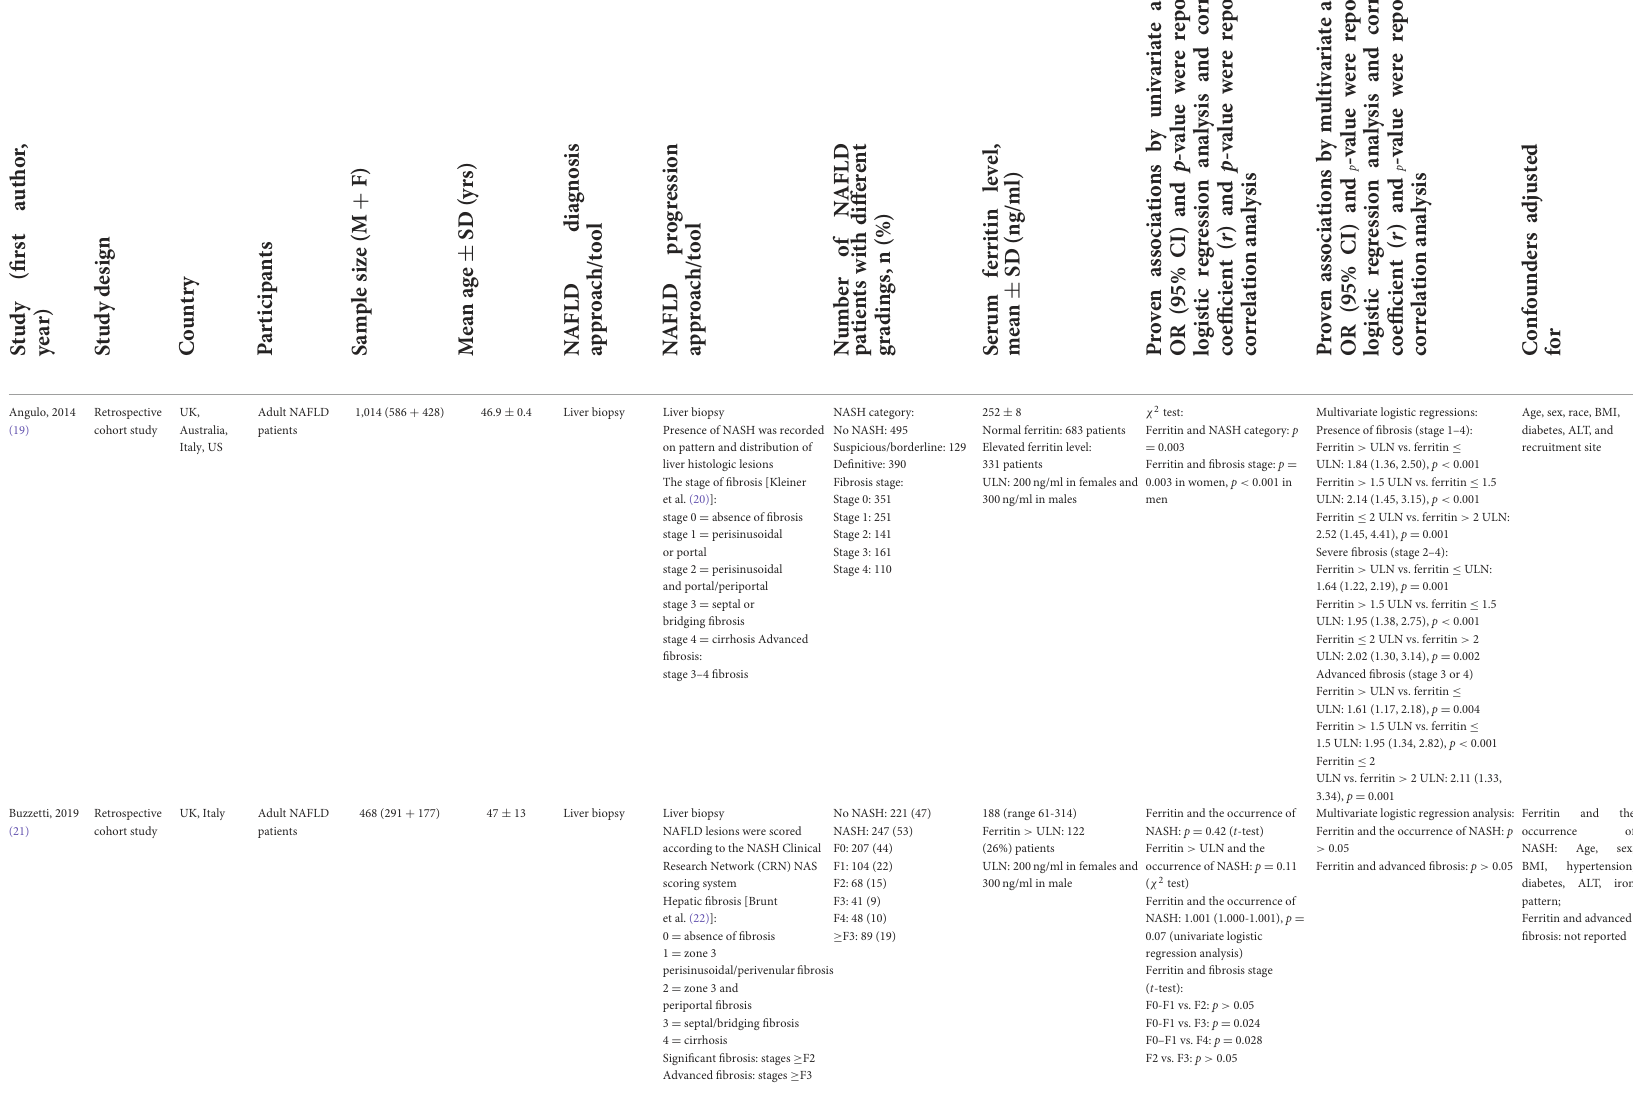
Ferritin and the occurrence of NASH: Age, sex, BMI, hypertension, diabetes, ALT, iron pattern; Ferritinandadvanced fibrosis:notreported